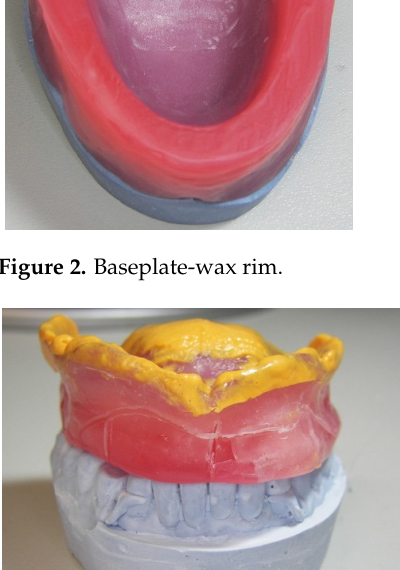
Figure 3. Maxillomandibular records and wash impression.